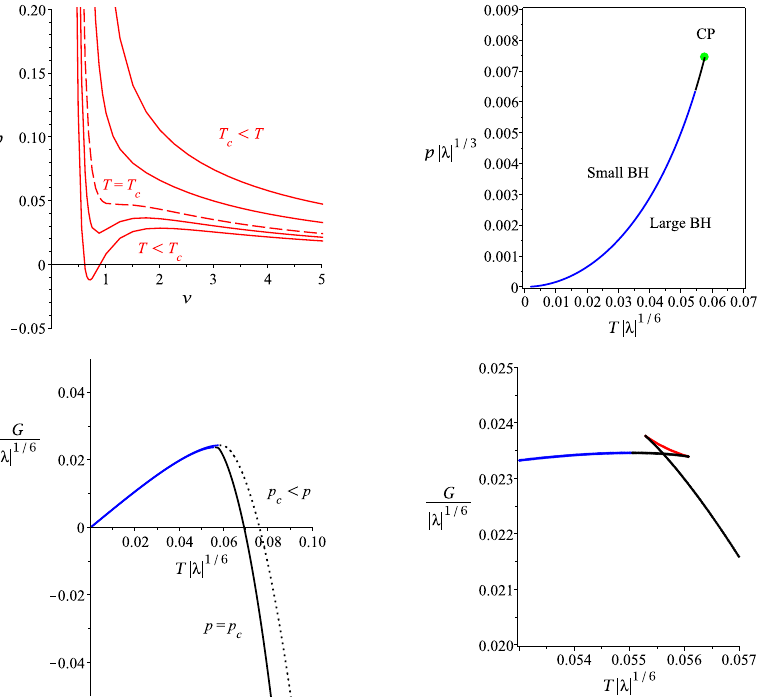
Figure 15 . Van der Waals behaviour in grand canonical ensemble for d = 4 and k = 1. Top left : isotherms in the P (cid:0) v plane, showing Van der Waals oscillations. The dashed red line corresponds to T = T c ; the solid red curves correspond to T 6 = T c . Top right : coexistence line in the P (cid:0) T plane for (cid:8) = 1. The green dot exhibits the critical point, and the black line is the line of coexisting phases for the (cid:12)rst order phase transition. The solid line has positive entropy, whereas the blue line indicates the occurrence of negative entropy. Bottom left : free energy vs temperature for various pressures. Solid black curves correspond to P = P c , and the dotted black curve marks pressures P > P c . The solid blue line has positive speci(cid:12)c heat but negative entropy. Bottom right : for P = 0 : 9 P c and (cid:8) = 1, the phase transition illustrated by swallowtail behaviour that grows by decreasing pressure. The red curves represent negative speci(cid:12)c heat with positive entropy; the blue curves represent positive speci(cid:12)c heat but negative